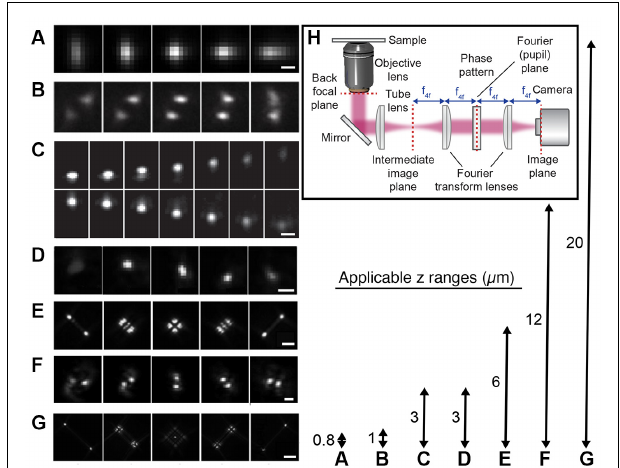
FIGURE 4 | Engineered point spread functions (PSFs) for single-molecule localization allowing tracking and super-resolution imaging in 3D. The arrows (right) represent both the available axial ranges and the range over which the different PSFs were imaged, except in the case of the DH PSF that was imaged over a 3 µ m axial range. (A) Astigmatic (Huang et al., 2008b). The scale bar is 0.5 µ m. Reprinted from Huang et al. (2008b). Reprinted